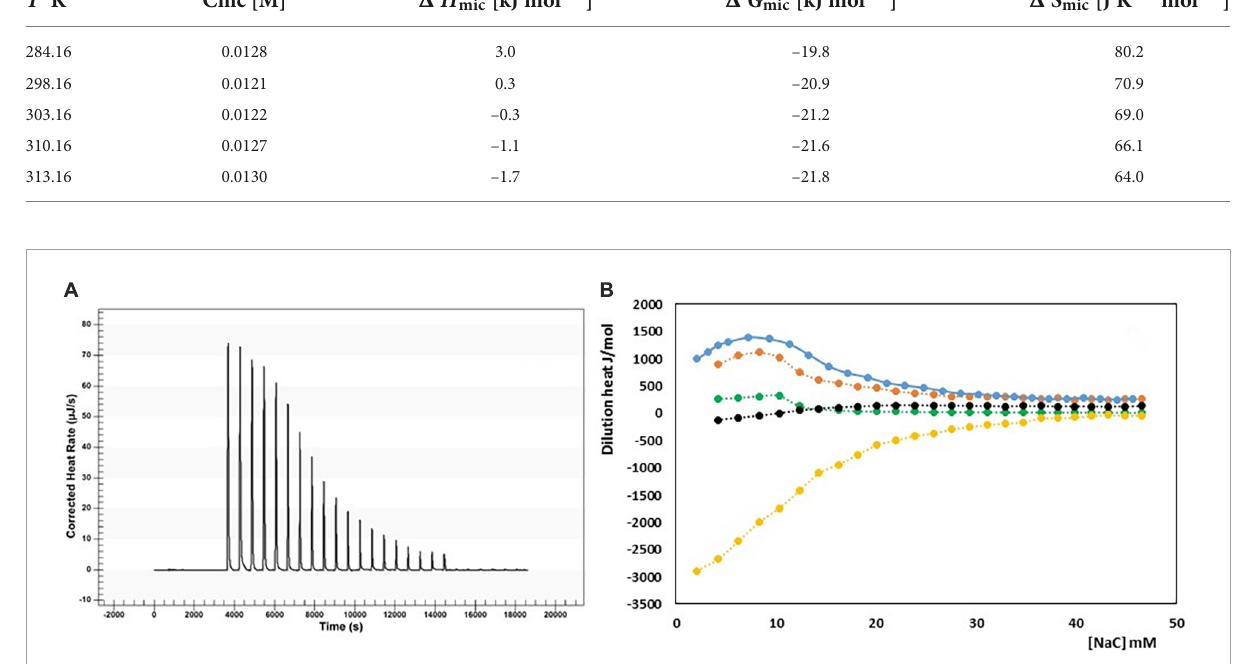
FIGURE1 (A) Output of the ITC experiment carried out at 11 ◦ C (25 injection of 10 µ L, each); (B) trends of molar dilution heats as a function of NaC concentration in the calorimetric cell, starting from a titrating solution 200 mM: 284.16 ◦ K (yellow), 298.16 ◦ K (black); 303.16 ◦ K (green); 310.16 ◦ K (red); 313.16 ◦ K (blue).